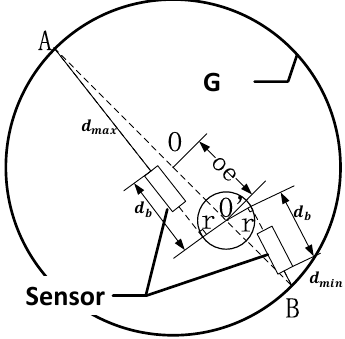
Figure 3. The calibration principle of tangential circles radius r and base circles radius 𝑑 𝑏 . Sensors 2017 , 17 , 294